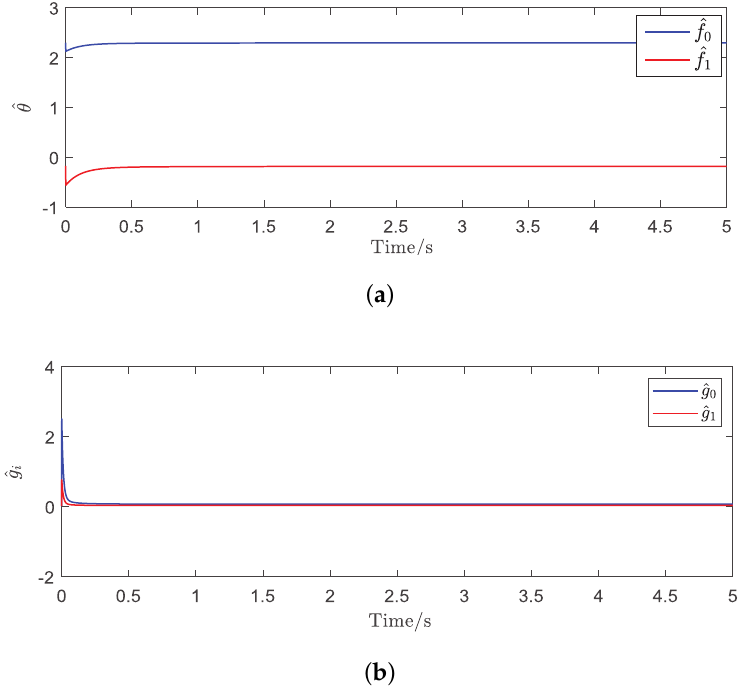
Figure 8. Estimated parameters ˆ θ and ˆ g i of the proposed adaptive controller for the triangular wave signal. ( a ) convergent curve of ˆ θ ; ( b ) convergent curve of ˆ g i .